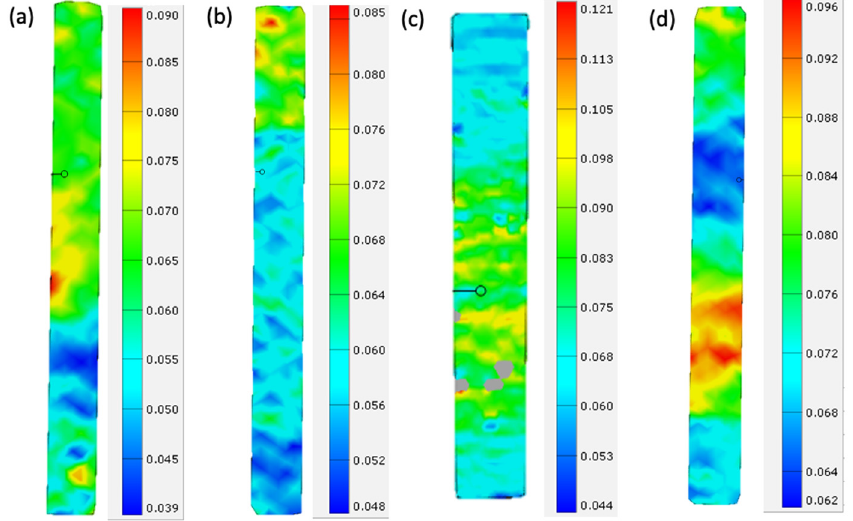
Figure 15. DIC images for Specimen ( a ) 5, ε = 6.2%, ( b ) XY2, ε = 6.0%, ( c ) 7, ε = 7.6%, and ( d ) XZ2, ε = 7.6%.